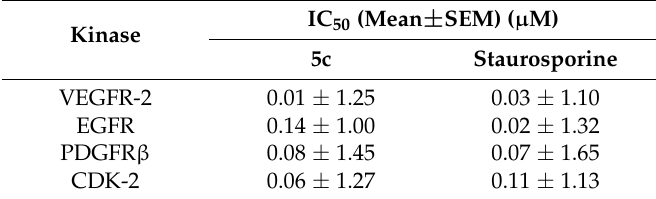
Table 2. Inhibitory evaluation of compound 5c against VEGFR-2, EGFR, PDGFR β and CDK-2 kinases.